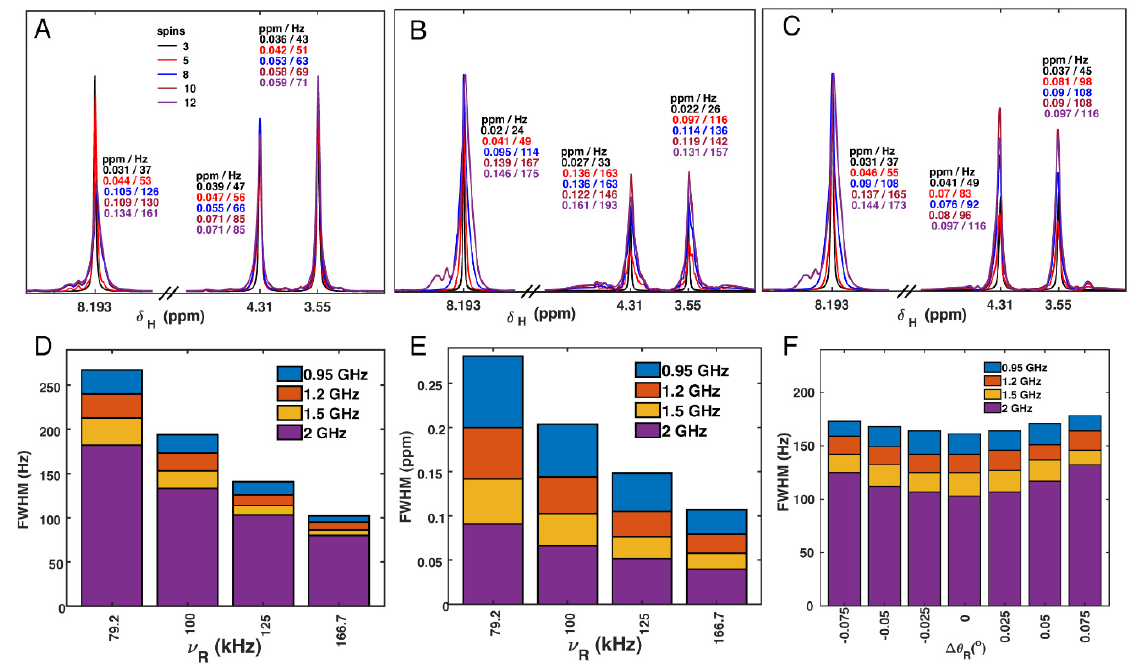
Figure 7. Simulated spectra of glycine protons (G34), with different sets of spins included. The simulated spectra in ( A – C ) were for the 1200 MHz magnet with 100 kHz MAS. In ( A ), the closest 3 to 12 spins from pdb 2N70 were included stepwise (details in the Supplementary Materials, Table S3). In B and C, two additional protons were added to fill a void near the G34 H α protons. In ( B ), these additional protons had chemical shift offsets of 4.6 ppm, whereas in ( C ), chemical shift offsets were set according to a DFT calculation (details in the Supplementary Materials). In ( D ), the full linewidth at half max (FWHM) of the amide proton is shown for four fields and MAS frequencies, with units of Hz. 12 spins were simulated. In ( E ), the same linewidths are shown in ppm. Panel ( F ) shows the sensitivity of the amide proton to magic angle misset. 12 spins were simulated at a spinning frequency of 100 kHz, for the indicated spectrometer frequencies. For ( A – E ), 32 Hz Lorentzian line broadening was applied, and for ( F ), 16 Hz was applied, since the panel represents the linewidth in a spin echo.